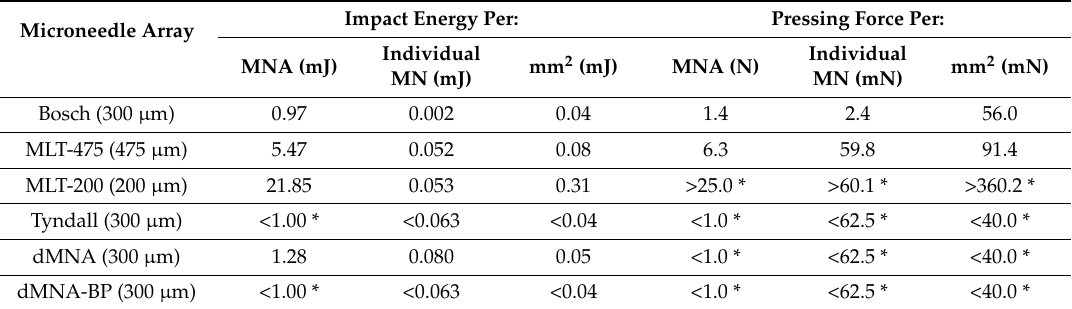
Figure 10. Penetration efficiency (in percentage) on ex vivo human skin as a function of the microneedle impact energy ( A , C ) and pressing force ( B , D ) both normalized for microneedle number (MN) ( A , B ) and microneedle array surface area (MNA surface) ( C , D ). Data are shown as mean ± SD ( n = 3). Table 5. EC50 values calculated from the penetration efficiency as a function of impact energy or pressing force. The EC50 values are reported per microneedle array or normalized per microneedle and per microneedle array surface